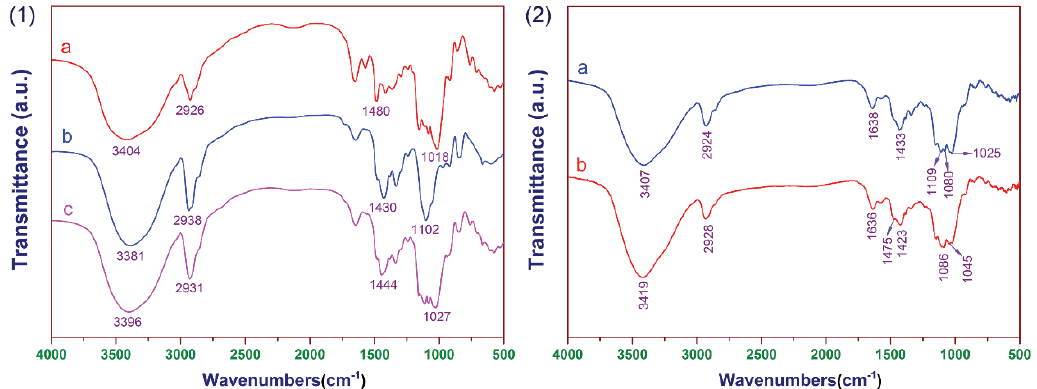
Figure 3. ( 1 ) The FT-IR spectra of ( a ) cross-linked cationic starch (CCS), ( b ) cross-linked cationic PVA (CCP), and ( c ) CCSP with a mass ratio of CS / CP of 1:1 (CCSP2). ( 2 ) The FT-IR spectra of the mixture adsorbent was composed of CCSP2 and activated carbon (AC), ( a ) before and ( b ) after treating the textile wastewater.